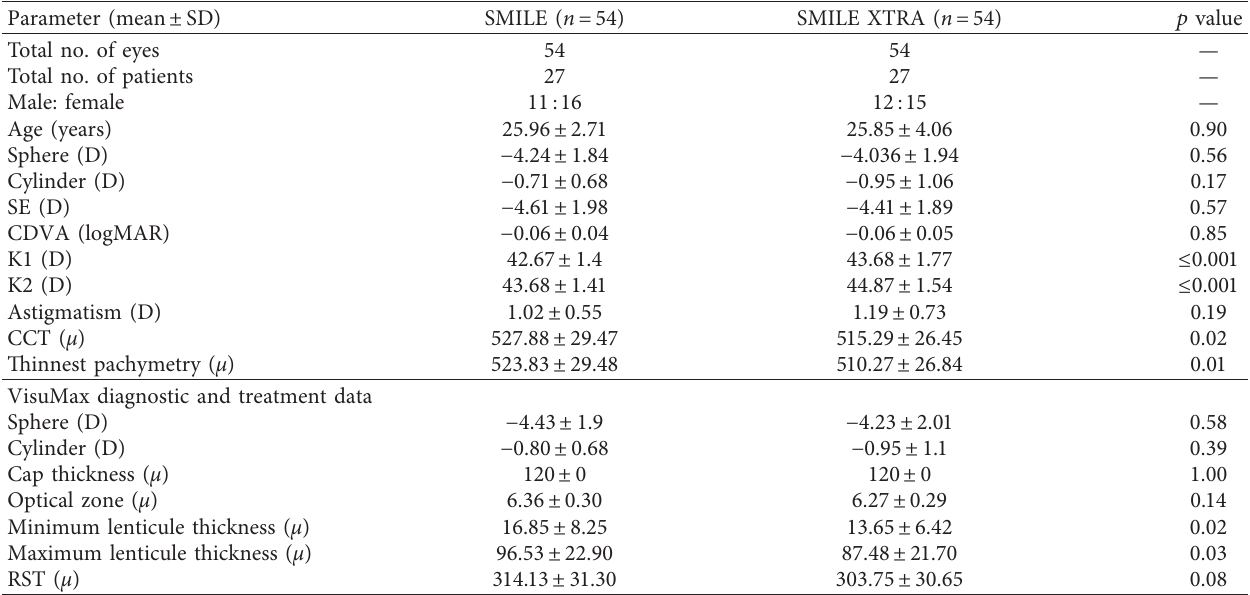
Table 1: Patient demographics and preoperative data.